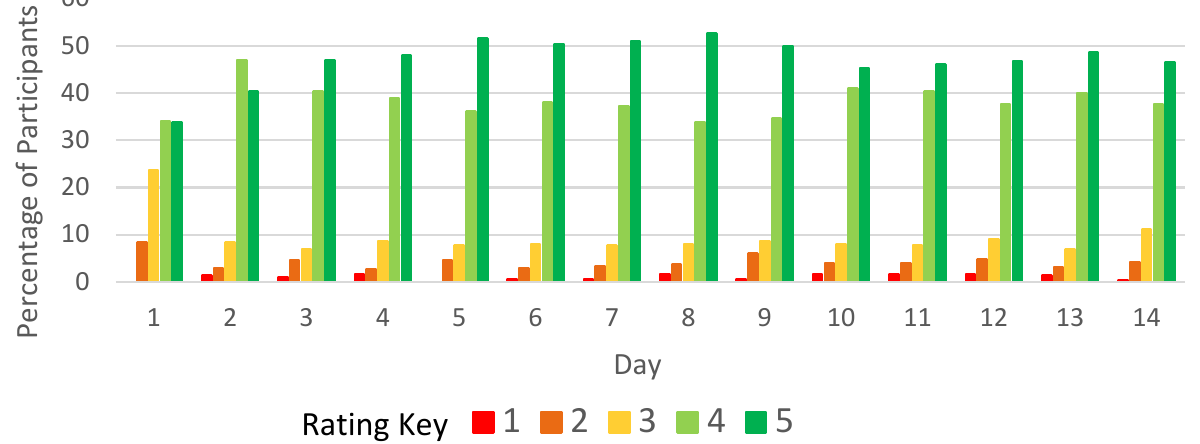
Scheme 9. Average daily survey ratings (parents). Average ratings from all five categories (Setting the Dose, Connecting the Syringe, Dispensing the Multiparticulate, Accuracy of the Dose, and